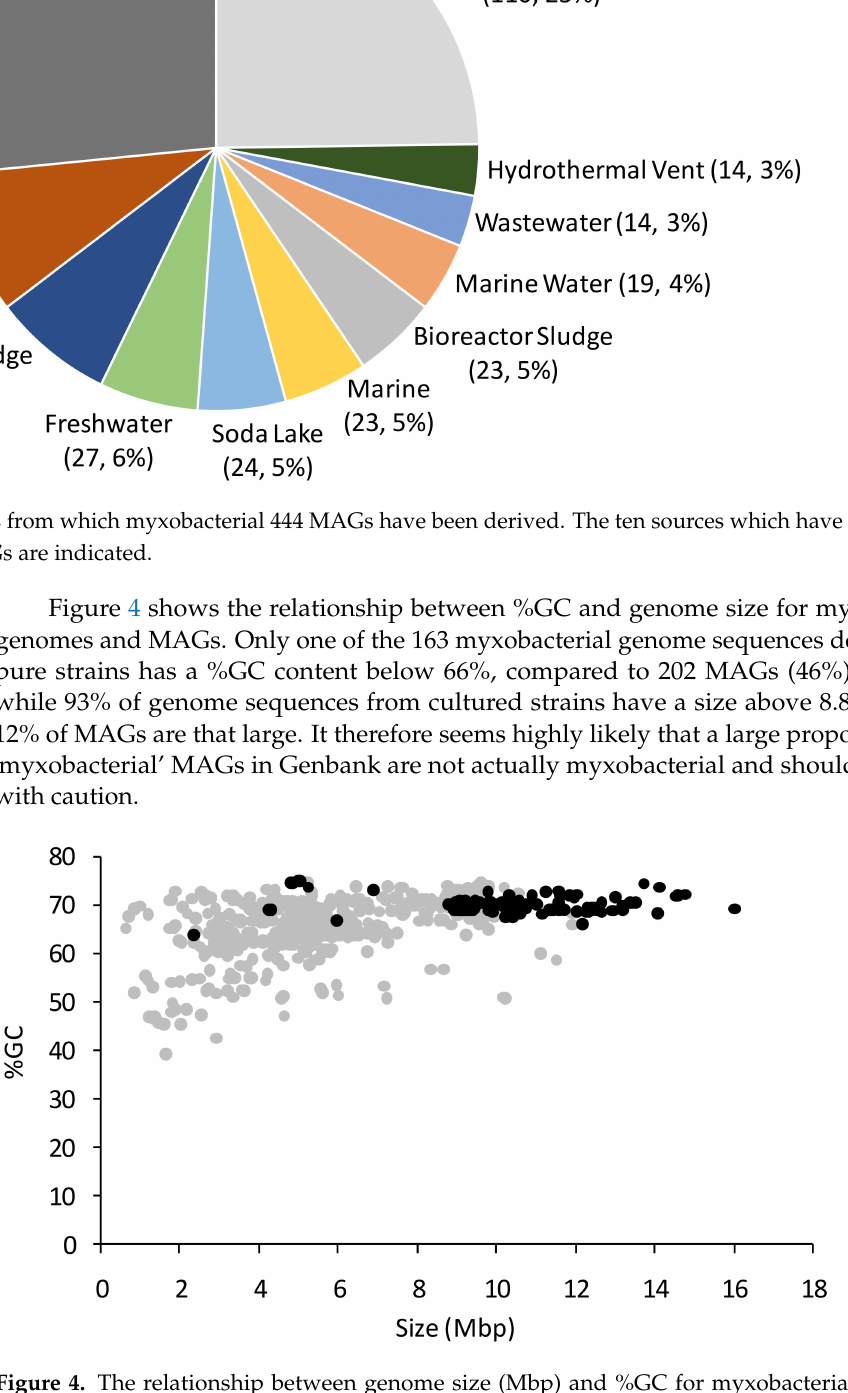
Figure 4. The relationship between genome size (Mbp) and %GC for myxobacterial genome se- quences (black) and MAGs